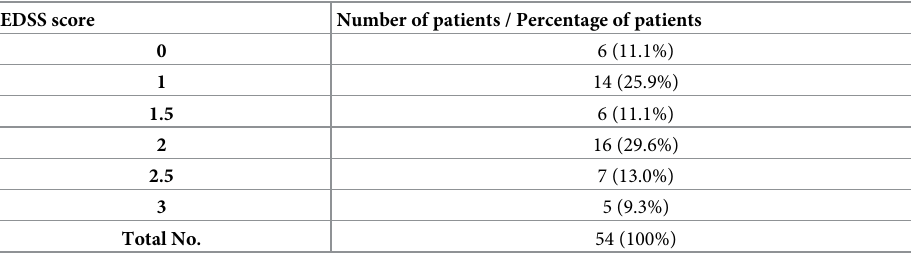
Table 1. Expanded Disability Status Scale score in patients with pediatric multiple